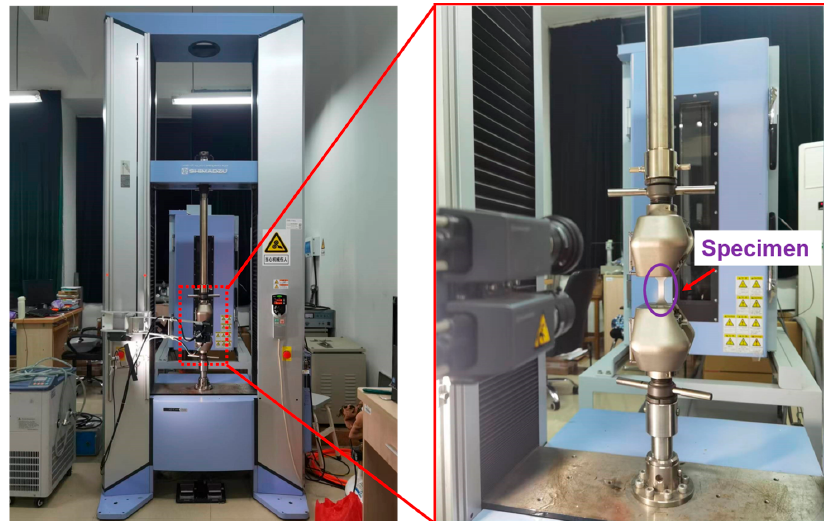
Figure 2. Overview of uniaxial tensile test.